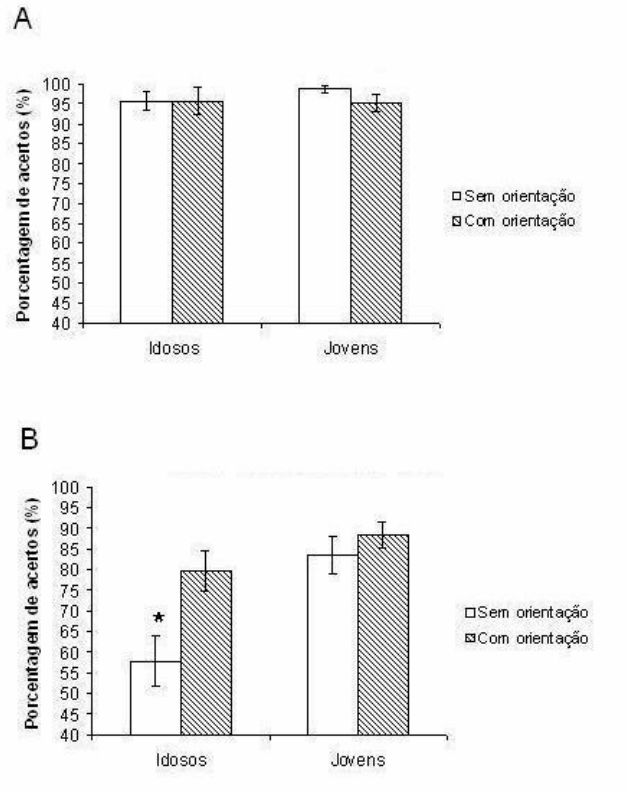
Figura 1. Porcentagem de acertos de idosos e jovens submetidos às tarefas de reconhecimento do objeto (a) e de memória contextual